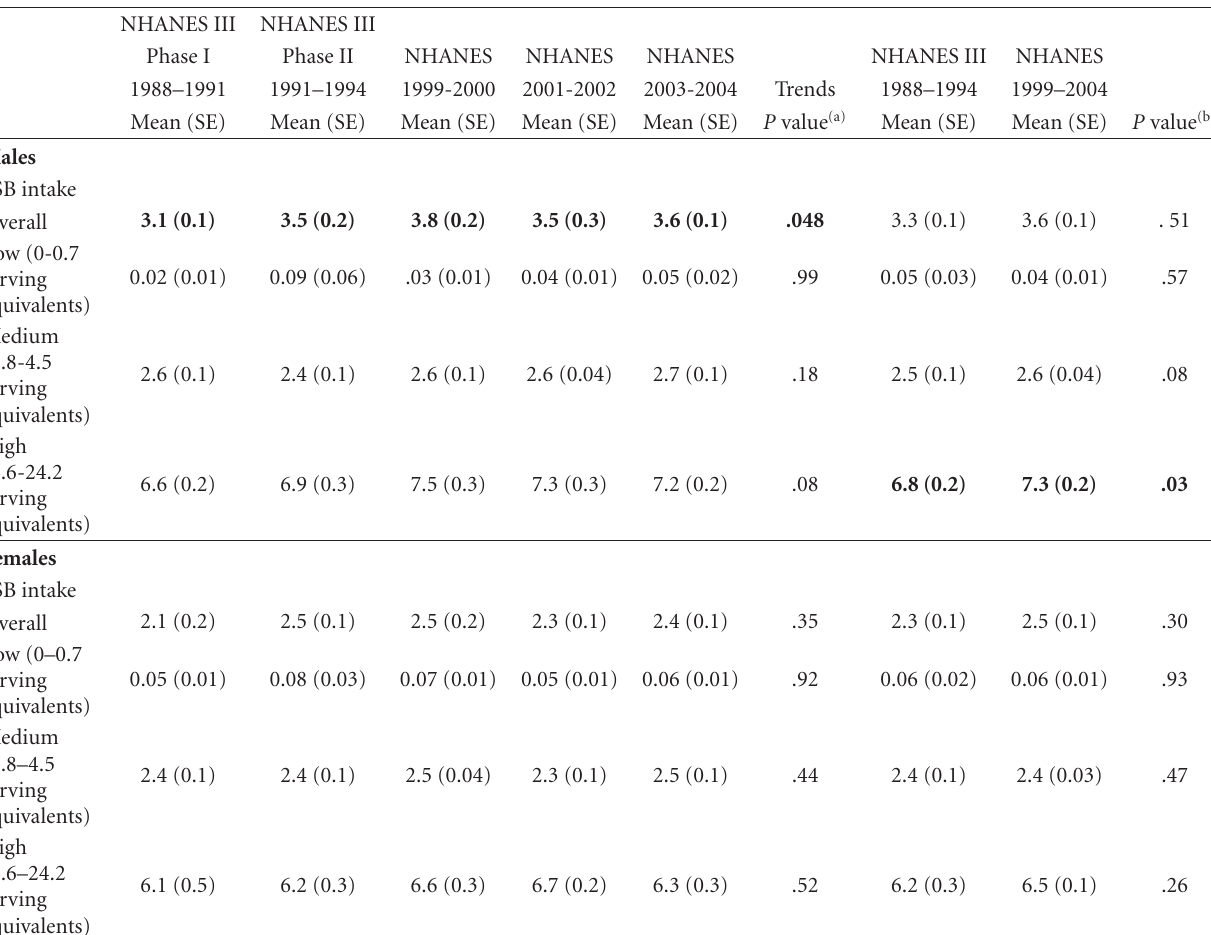
Table 3: Trends in SSB Intake among adolescents aged 12–19 years by sex: NHANES III (1988–1994), NHANES 1999-2000, NHANES 2001-2002, and NHANES 2003-2004. Low SSB intake defined as lowest quintile based on NHANES III cuto ff s; medium defined as 2nd–4th quintiles; high defined as highest quintile. Mean indicates mean number of serving equivalents of sugar-sweetened beverages reported during 24 hour dietary recall. Significant results are in bold . Abbreviations: SSB, sugar-sweetened beverage; SE, standard